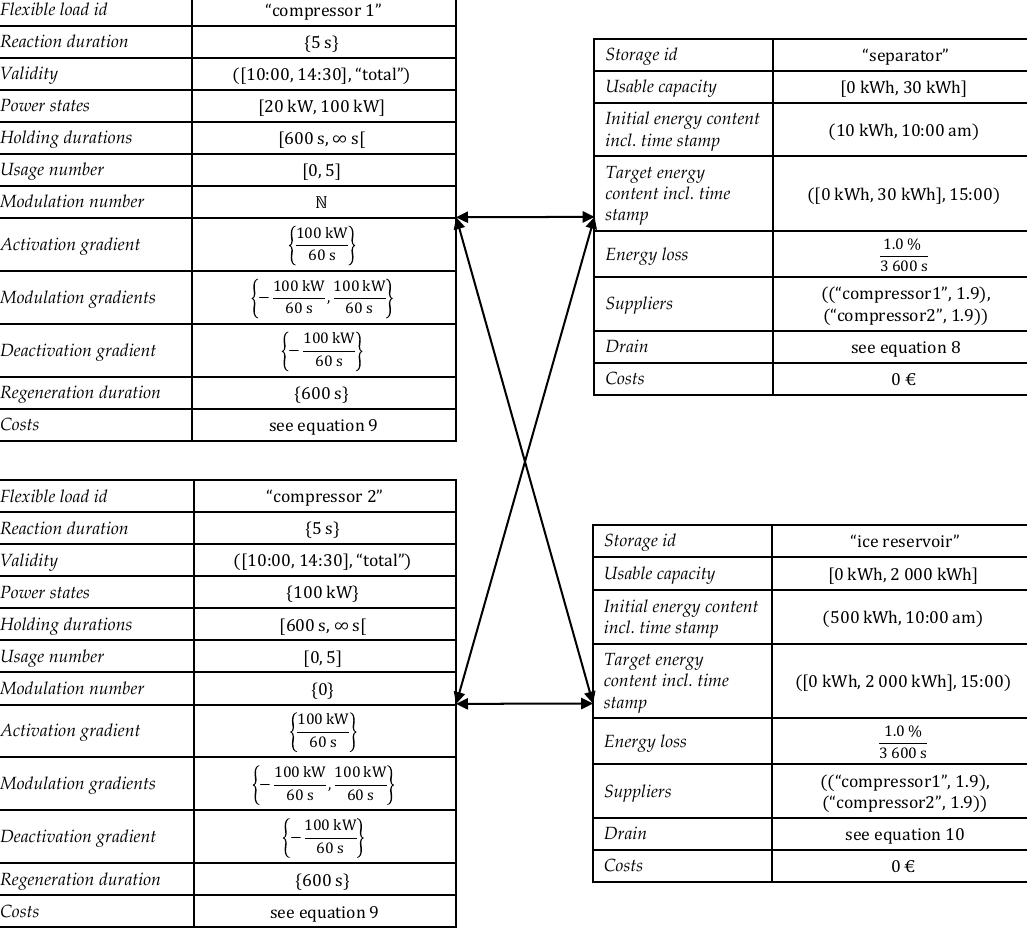
Figure 11. The data model for the two flexible loads and the two